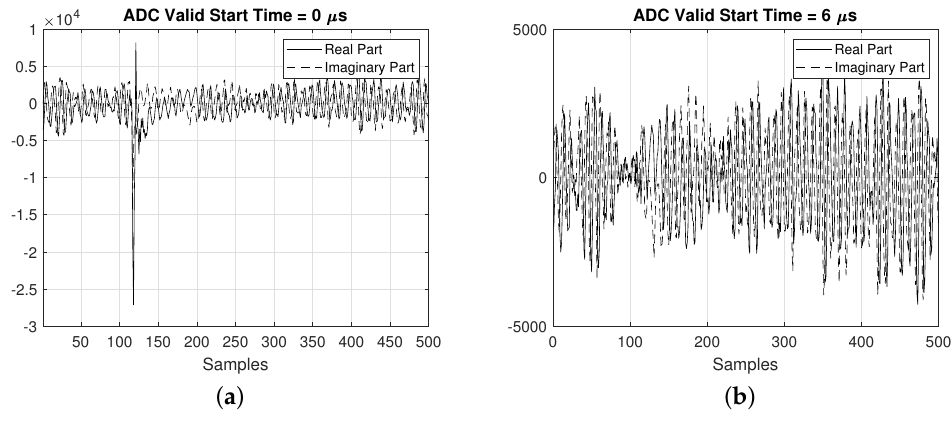
Figure 3. IF signal ( a ) without guard interval, highlighting the presence of a spike, and ( b ) with guard